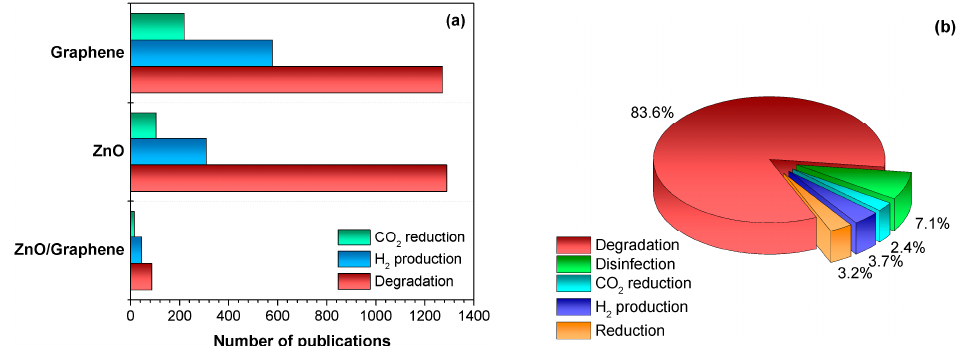
Figure 23. ( a ) Number of publications about some photocatalytic applications of ZnO, graphene, and ZnO–graphene composites; ( b ) distribution of the publications devoted to several applications of the ZnO–Graphene composites in photocatalysis (2016–2020).